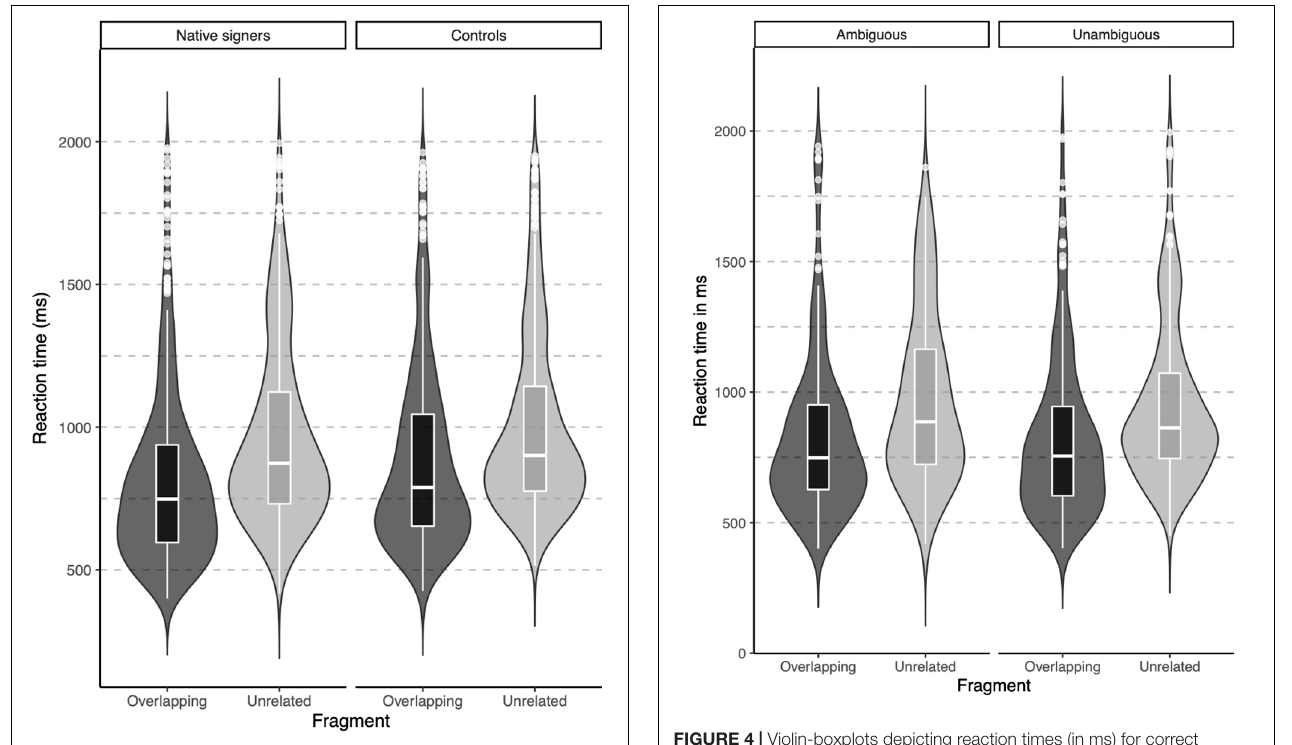
FIGURE 3 | Violin-boxplots depicting reaction times (in ms) for correct responses for Native signers (left) and Controls (right) for Overlapping (dark gray) and Unrelated (light gray) fragments.